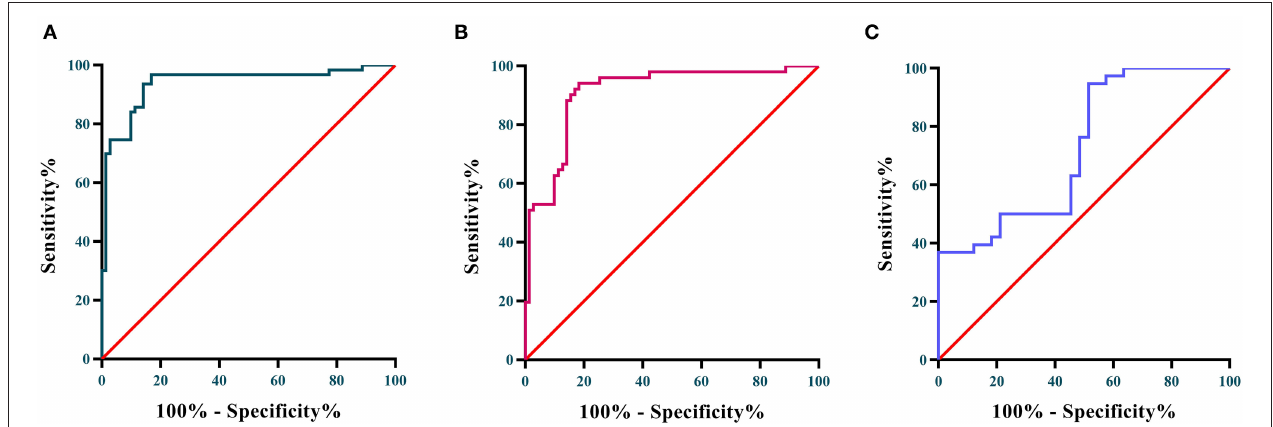
FIGURE 2 | (A) ROC curves of Lp-PLA2 for distinguishing KD patients from HCs; (B) ROC curve of Lp-PLA2 for distinguishing KD from FCs; (C) ROC curve of Lp-PLA2 for predicting the occurrence of